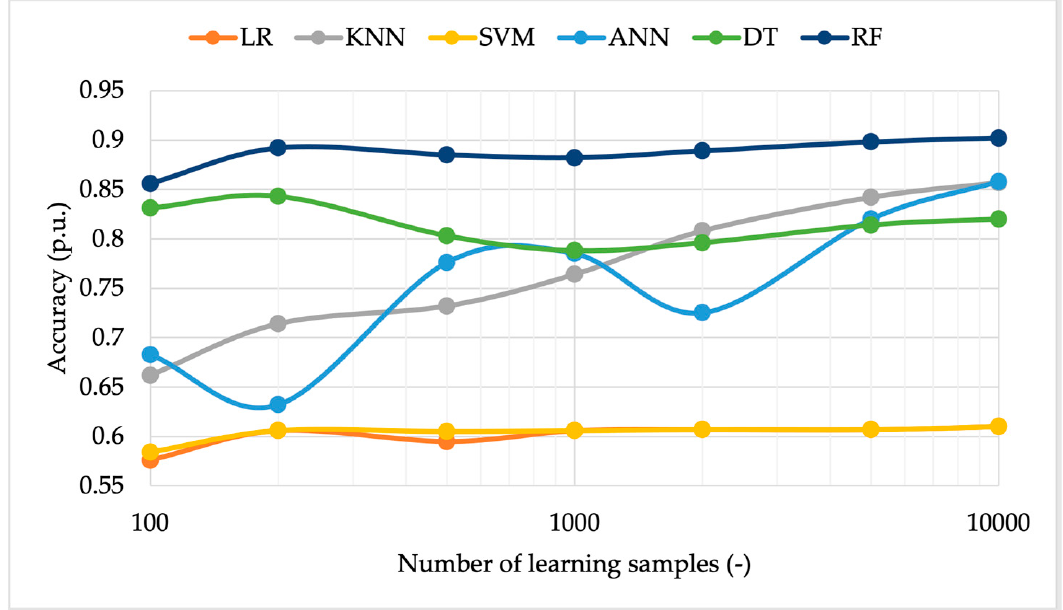
Figure 10. Algorithm accuracy vs. the number of learning samples using normal distributed inputs.